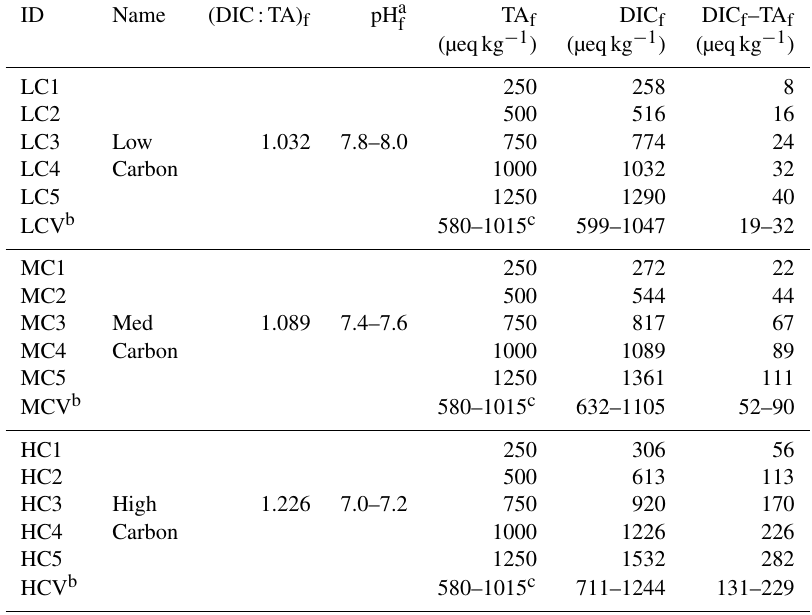
Table 2. Biogeochemical model freshwater endmember cases run for each year in the 2001–2012 year